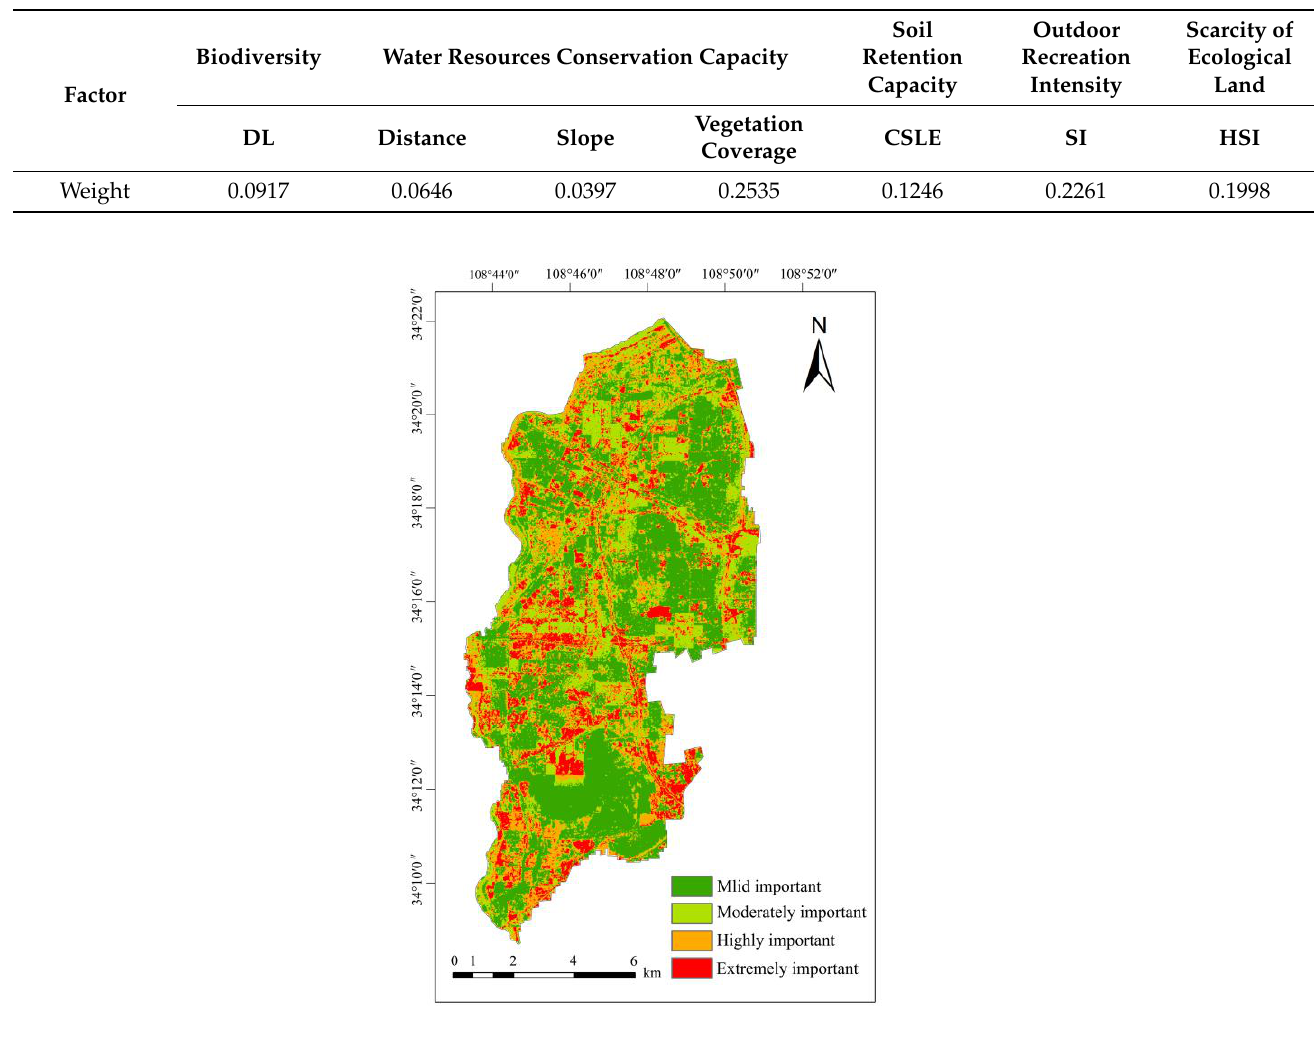
Table 3. The integrative weights of factors for evaluating the ecological values of urban green space.